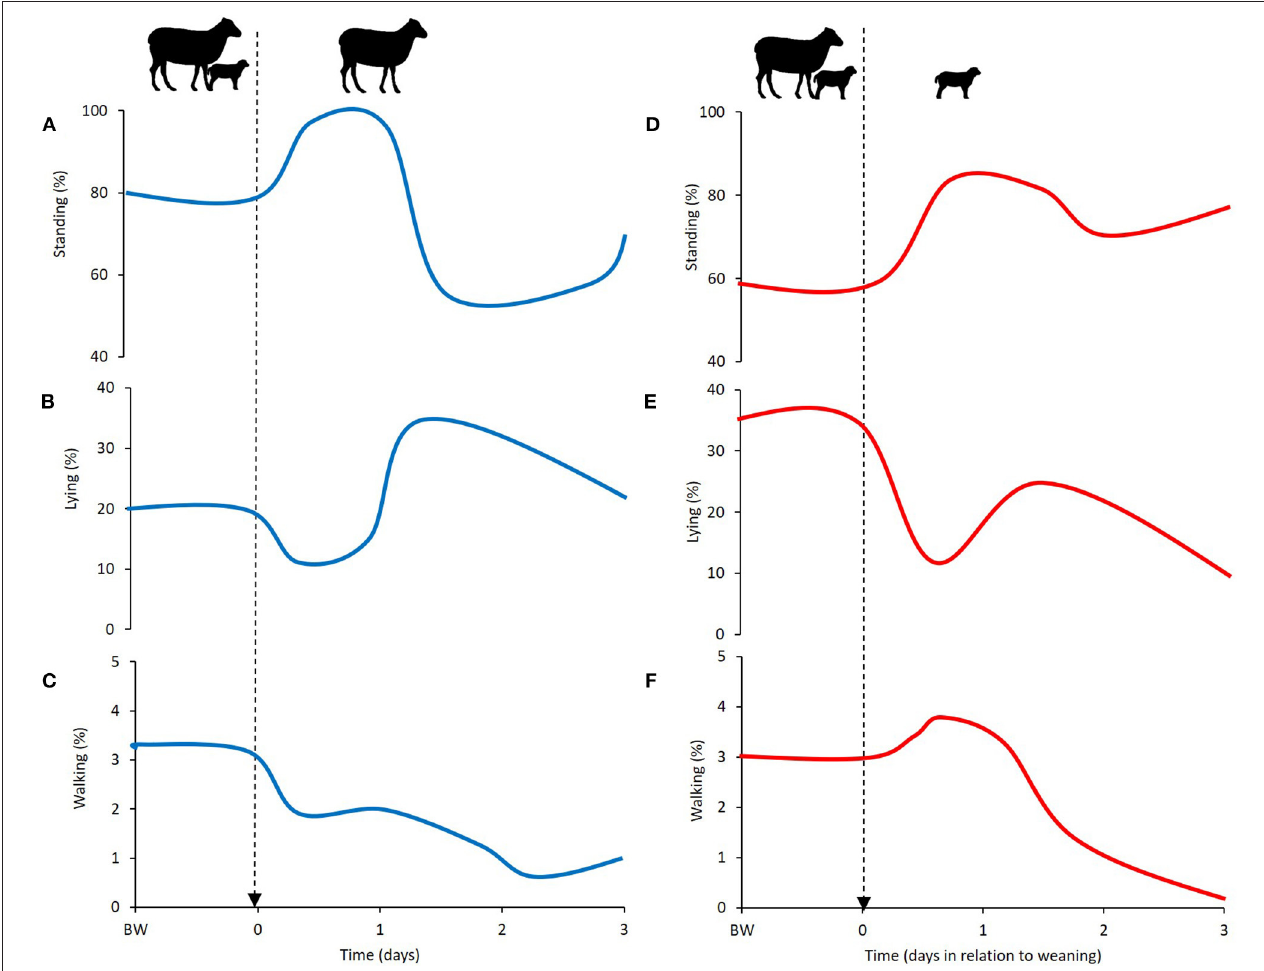
FIGURE 1 | Behavioural changes in ewes (left panel) and lambs (right panel) triggered by weaning (dotted arrow). The upper graphs show the time spent standing (A, D) , the medium panel the time spent lying (B,E) , and the more below one, the time walking (C,F) . The models are based in the data of Freitas-de-Melo and Ungerfeld